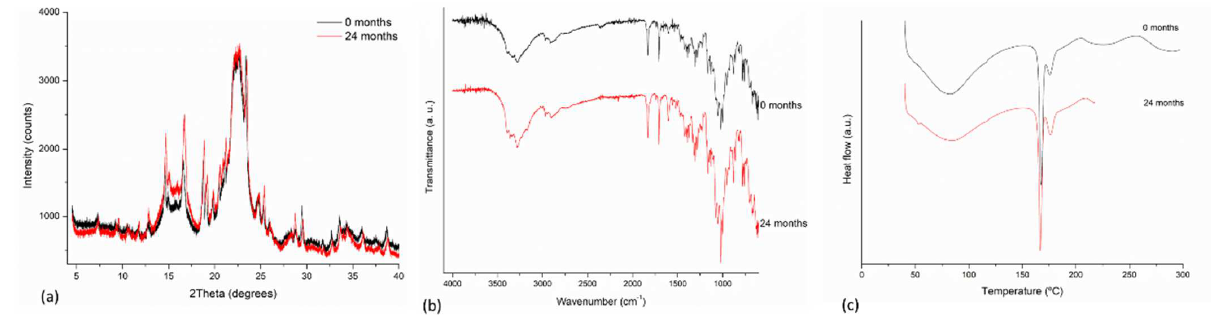
Figure 6. Solid-state stability determinations of F 1 freshly prepared and after 24 months of storage of product ( a ) PXRD, ( b ) FT-IR, and ( c ) DSC curves. Table 3. Drug content and percentage of labelled drug dissolved in the dissolution test for F 1 and F 2 formulations after 24 months of storage.